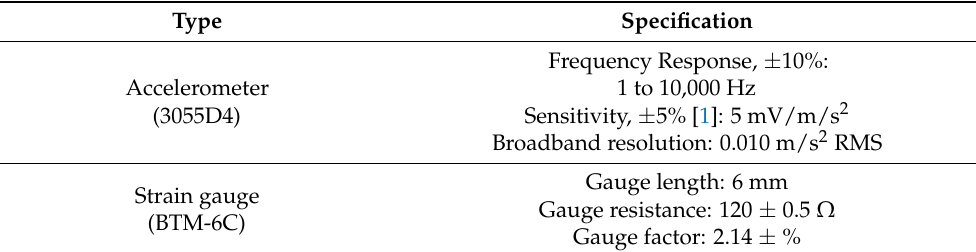
Table 1. Specifications of sensors in the smart bolt.